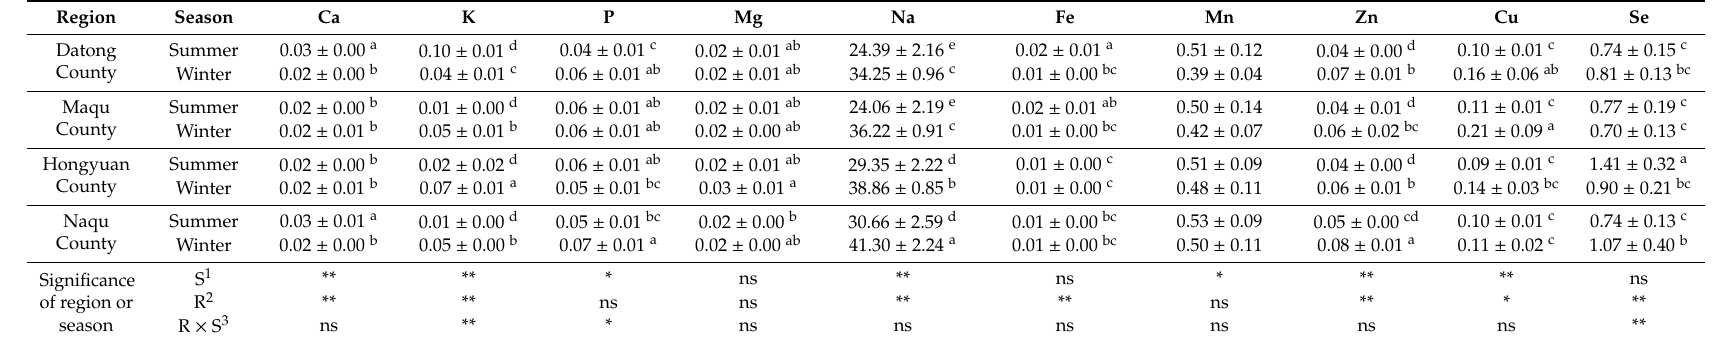
Table 5. Transfer factor (TF) in yak / plants (mean ±